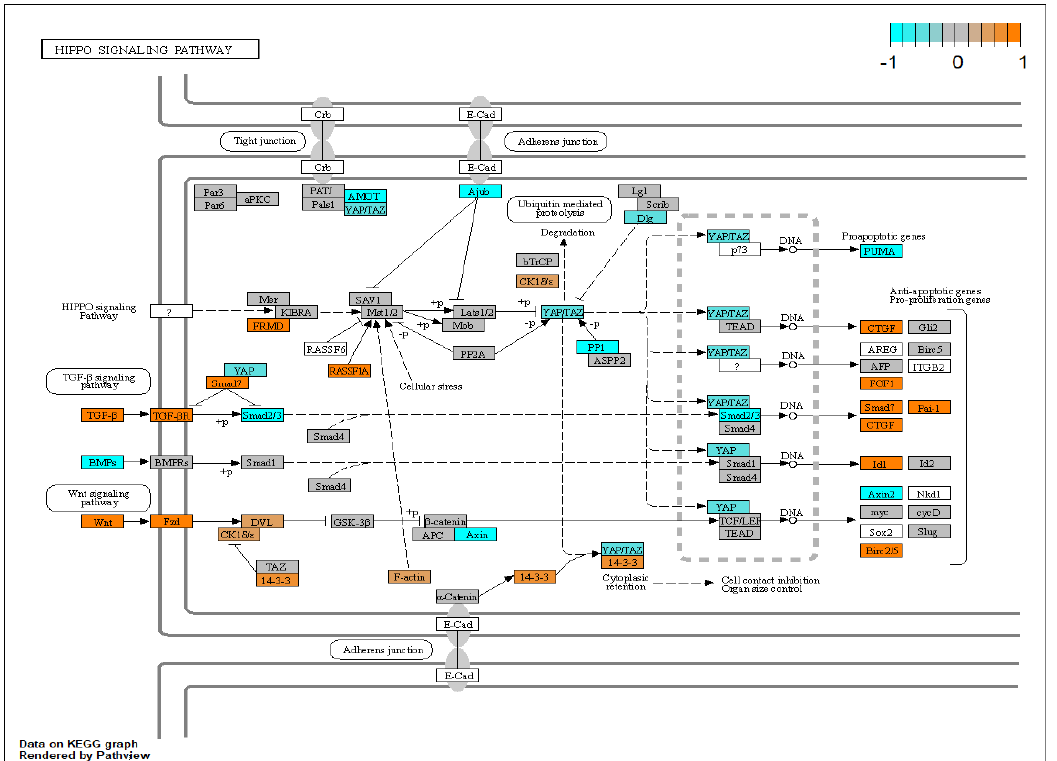
Figure 10. Annotation of genes in the KEGG generated hsa04390 pathway; the Hippo signaling pathway. Differentially expressed genes in the hsa04390 pathway have been annotated using R package Pathview. Gene expression has been normalised to a range of [-1, 1] to enhance visibility in which orange corresponds to upregulation while cyan corresponds to downregulation. Grey coloured genes are expressed but not differentially so. White coloured genes were not found to be expressed in our dataset.